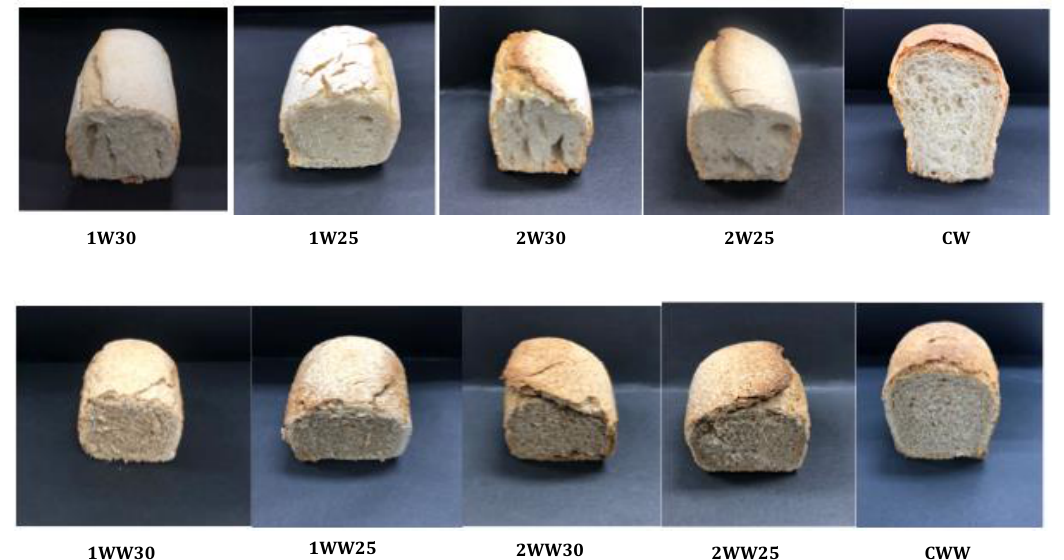
Figure 1. Visual appearance of sourdough and control breads.